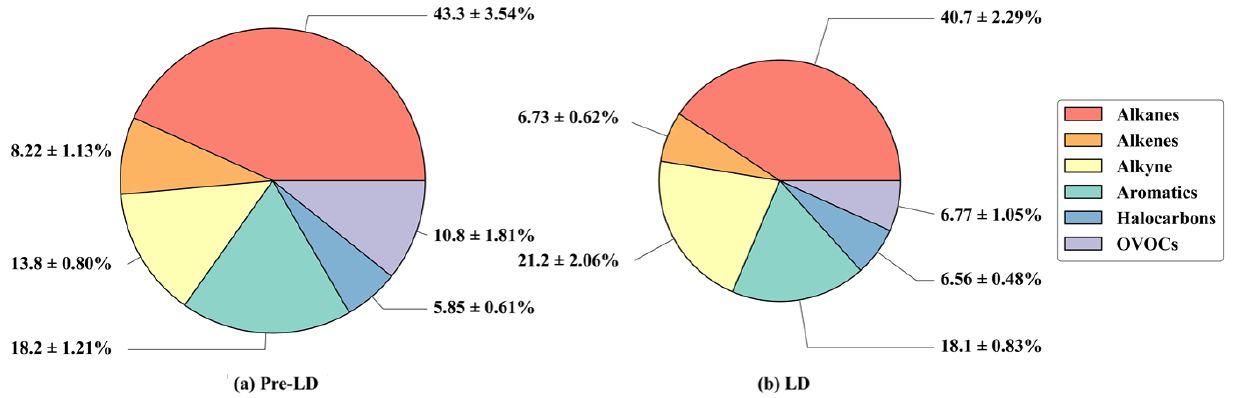
Figure 2. VOC compositions during the ( a ) Pre-LD and ( b ) LD in the shorter study period. Pie area is proportional to the mixing ratio of TVOCs. proportional to the mixing ratio of TVOCs.